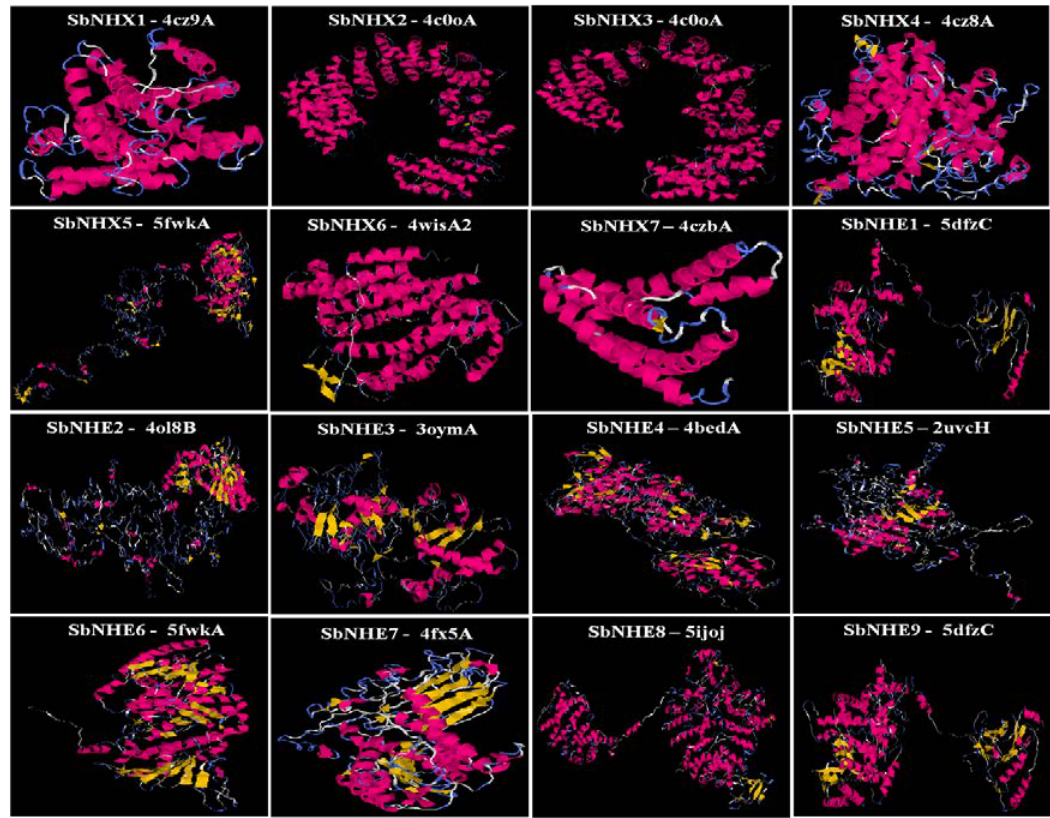
Figure 3. Structural analysis of seven SbNHX and nine SbNHE modeled proteins. The best Protein Data Bank (PDB) structural analog for each transporter is represented in the figure.